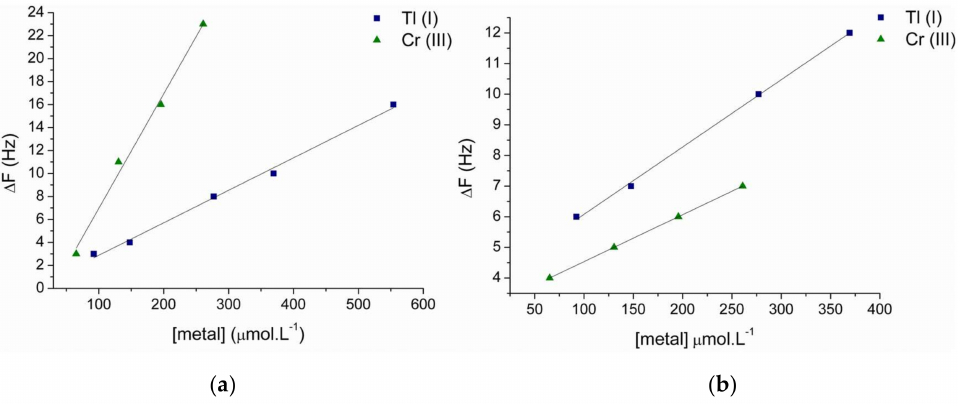
Figure 7. Response of the sensor to Tl + (blue) and Cr 3+ (green) based on: ( a ) NCTPP-Si and ( b ) NCTPP-Si-Py + .